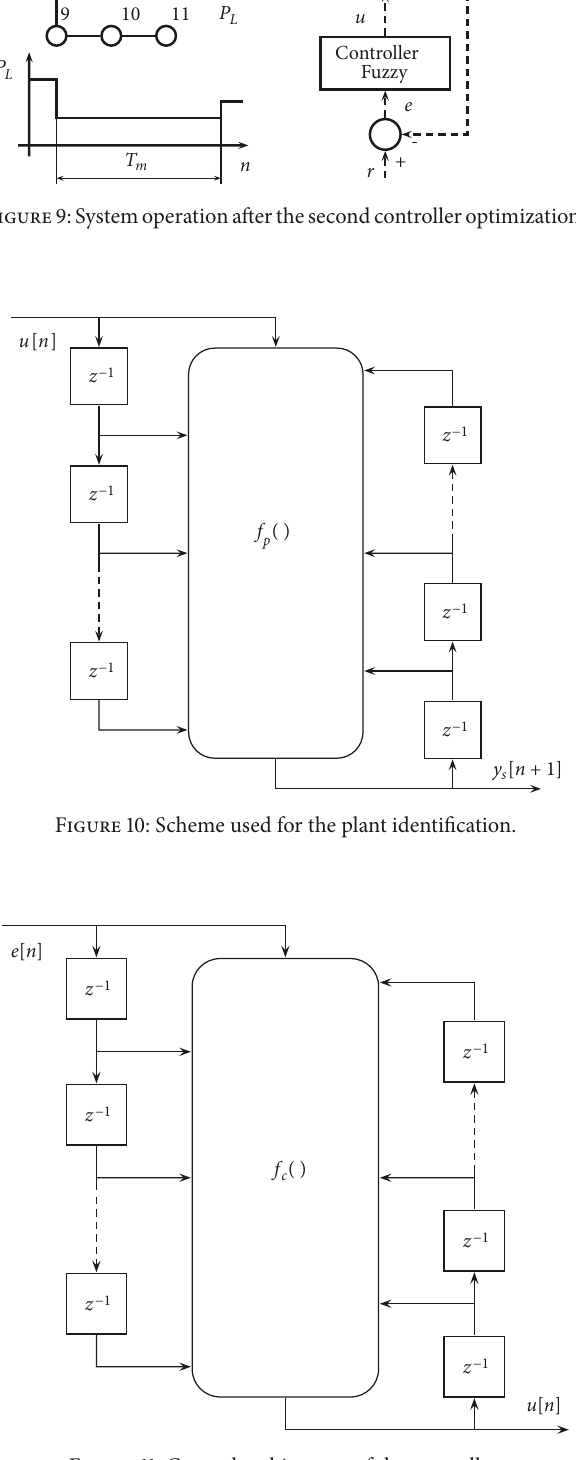
Figure 11: General architecture of the